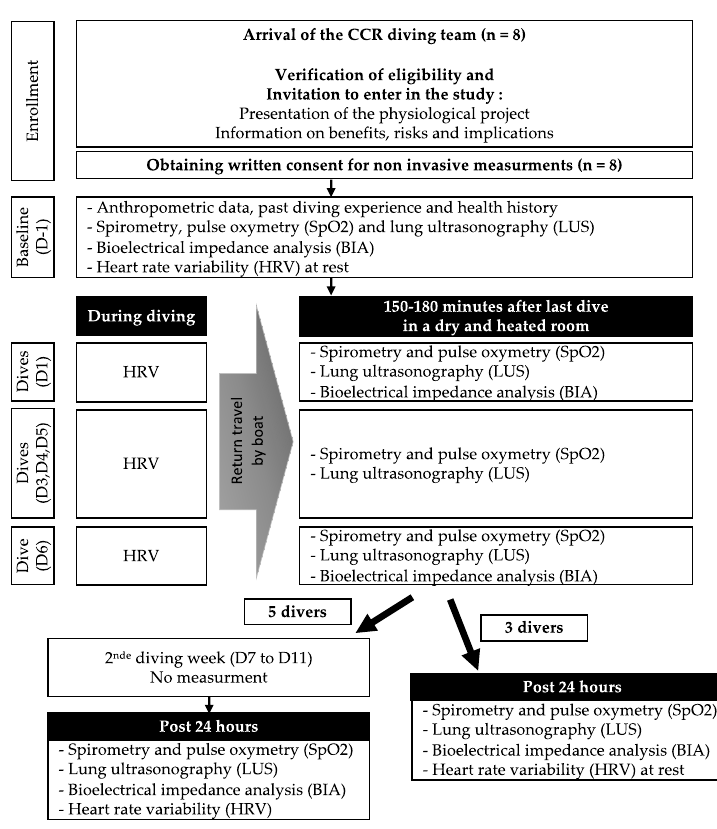
Figure 1. Experimental flowchart.